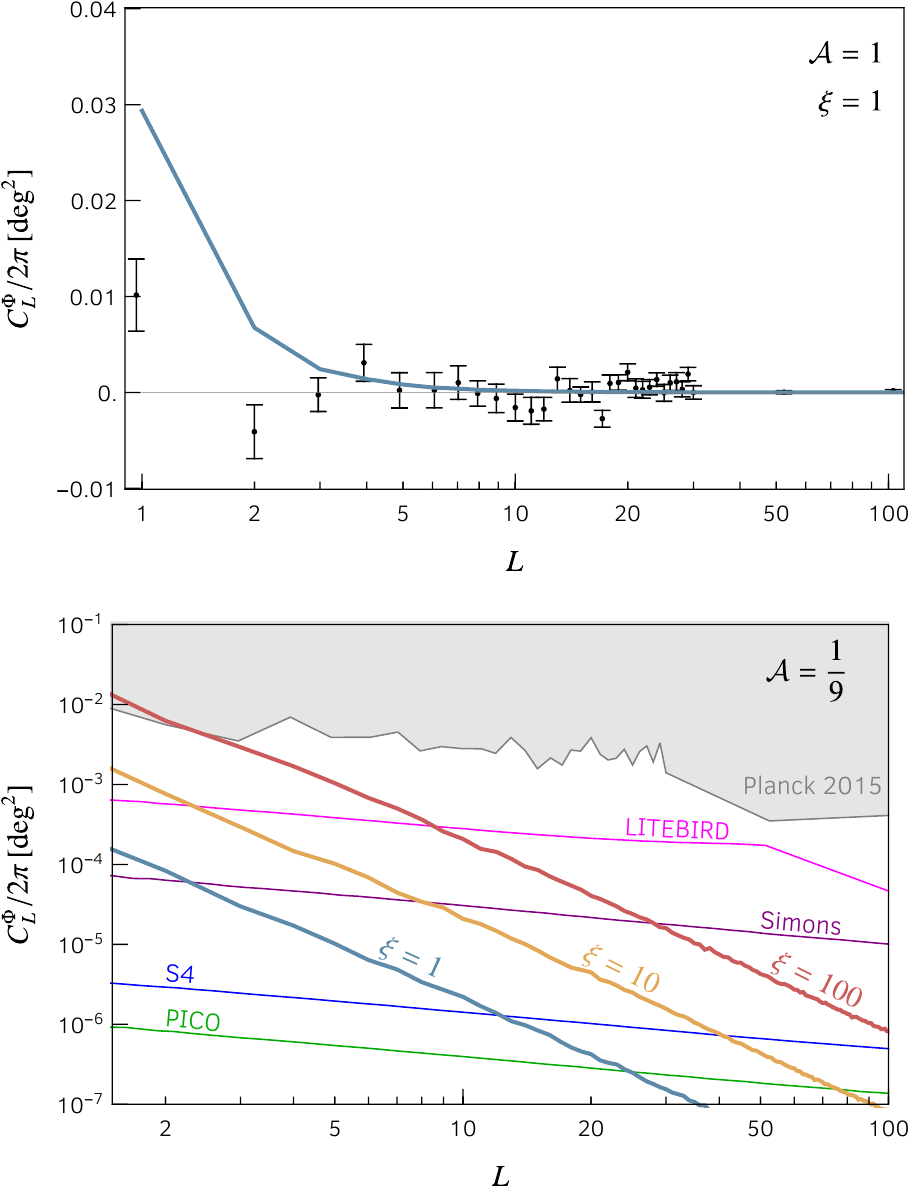
Figure 6 . Power spectrum of the polarization rotation angle. Top: constraints on the power spectrum derived from Planck 2015 polarization data (data points) [77]. The blue curve shows the power spectrum for (cid:24) = A = 1, which is of the order of the current sensitivity. Bottom: forecasts for the power spectrum measurements in future experiments [51]. The grey shaded region is excluded by Planck while the thin magenta, purple, blue and green lines show the sensitivity of future CMB experiments. The thick blue, yellow and red solid lines show the prediction for (cid:24) = 1 ; 10 ; 100 and A = 1 = 9. For both plots we have taken a mean over cosmic variance for our prediction. The power spectra can be scaled for other values of (cid:24) and A as C (cid:8) / (cid:24) A 2 . L